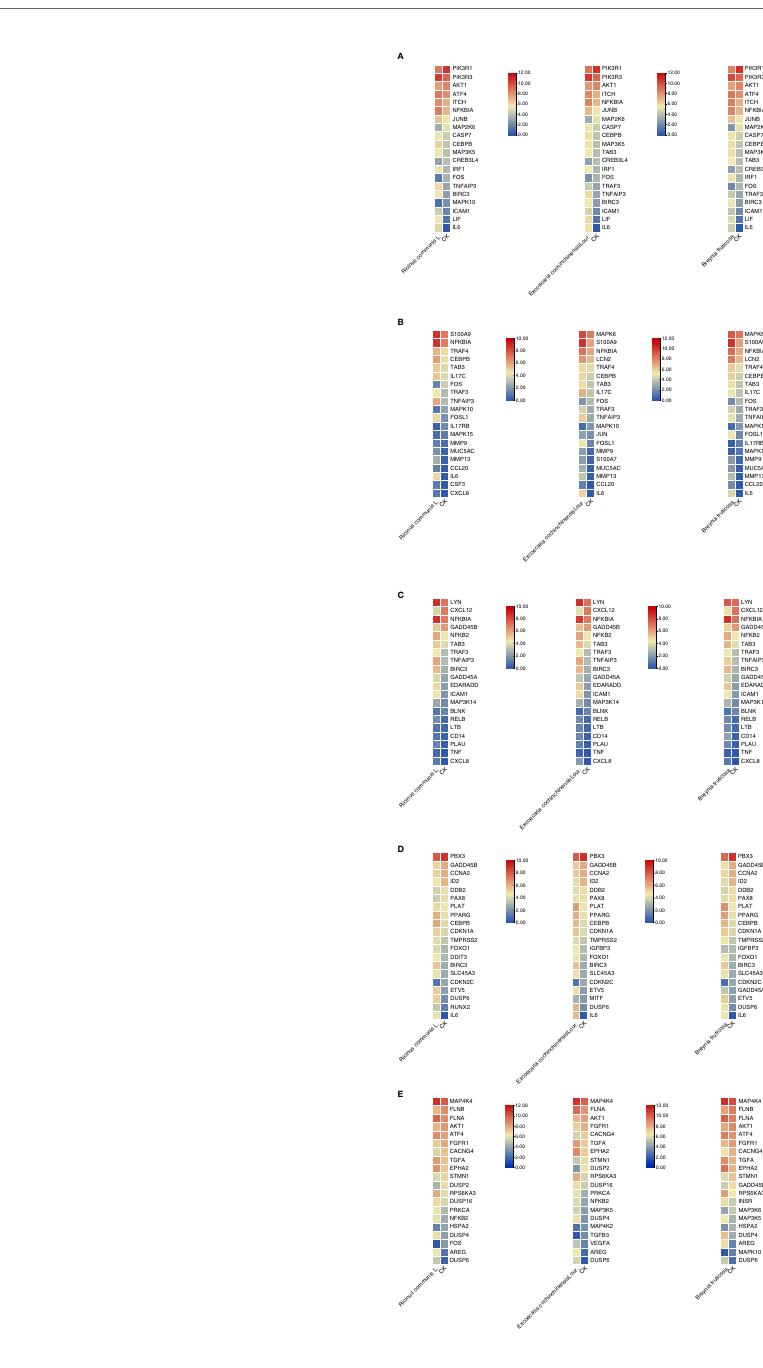
FIGURE 4 | Expression and regulation of the top genes enriched on these fi ve pathways in three candidate TCM. (A) TNF signaling pathway; (B) IL − 17 signaling pathway; (C) NF-kappa B signaling pathway; (D) Transcriptional misregulation in cancer pathway; (E) MAPK signaling pathway. R: R. communis L .; E: E . cochinchinensis Lour .; B: B . fruticose ; CK: the negative